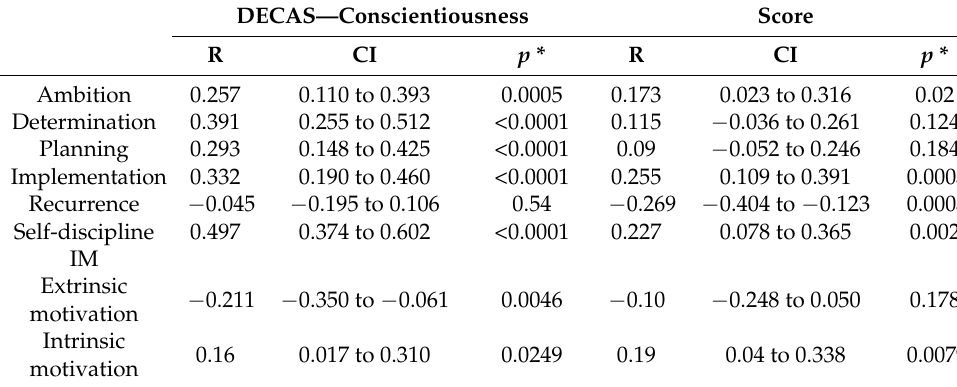
Table 4. Correlations between SPM, IM, and Conscientious and